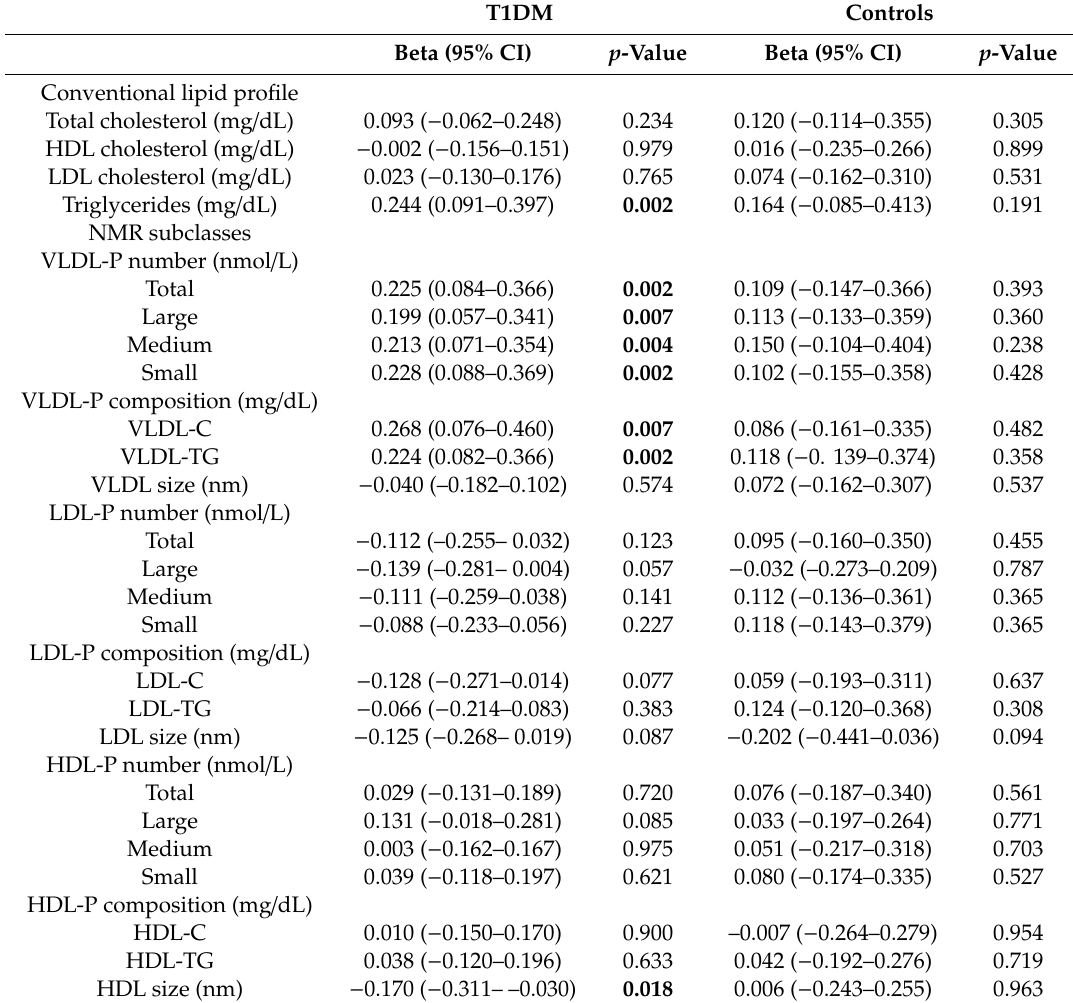
Table 3. Multiple regression analysis for the association between arterial sti ff ness and NMR-assessed lipoprotein subclass